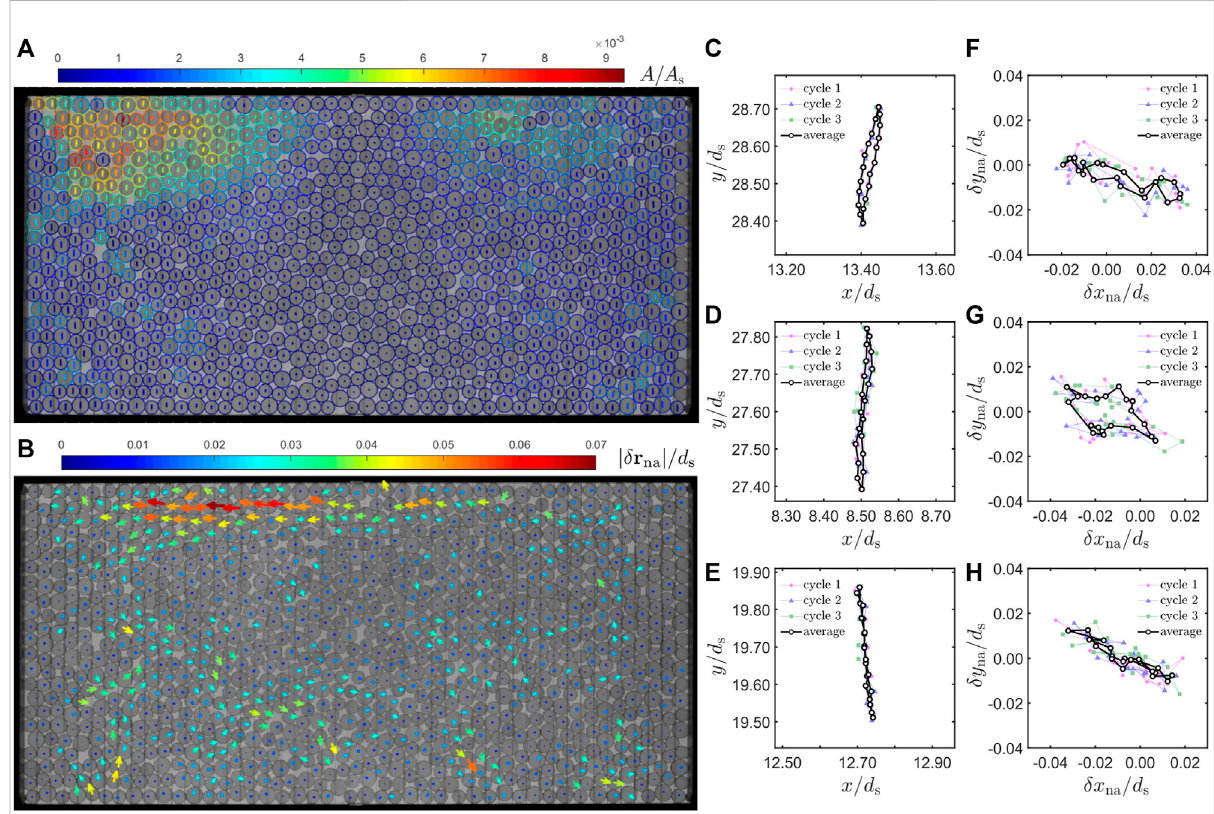
FIGURE 6 Particle center trajectories display non-af fi ne components and loops. All data in this fi gure are from the same example ultrastable state as in Figure3. (A) Particlecentertrajectoriesaveragedoverthreecompleteshearcyclesplottedontopofanunpolarizedimagetakenatthestartofacycle (state A in Figure 3A). The color of trajectories indicates the normalized enclosed area of the trajectory A / A s , where A s is the area of the small disc. Particle outlines are also colored as a guide to the eye. (B) The non-af fi ne displacement fi eld from state B to state D in Figure 3A superimposed on the same unpolarized image as in (A) . The arrow lengths are 20 times larger than the actual displacements, and colors indicate the displacement magnitudes | δ r na |/ d s ,where d s isthediameter ofthesmalldisc (C – H) Threeexample particlecentertrajectories (C – E) and